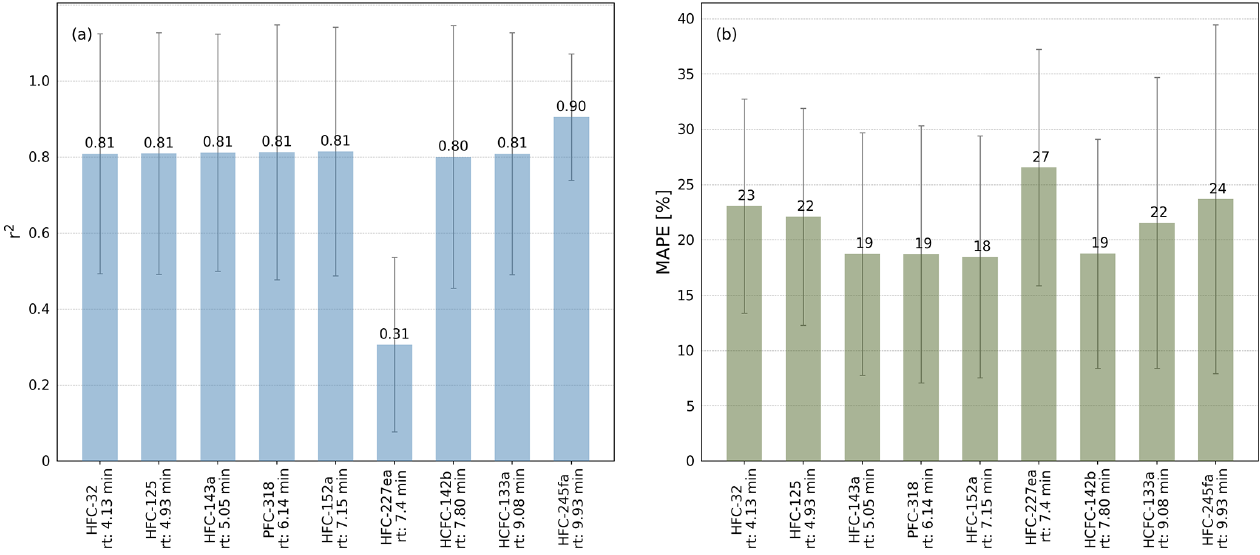
Figure 3. Means of the coefficient of determination ( r 2 ) in panel (a) and means of mean absolute percentage error (MAPE) in panel (b) of the comparisons of the peak areas of HFC-32, HFC-125, HFC-143a, PFC-318, HFC-152a, HFC-227ea, HCFC-142b, HCFC-133a, and HFC-245fa to all other substances based on measurements of calibration standards using the laboratory TOF-MS setup in the phase where calibration cylinder GUF-10 was used. Error bars indicate the standard deviations (1 σ ).